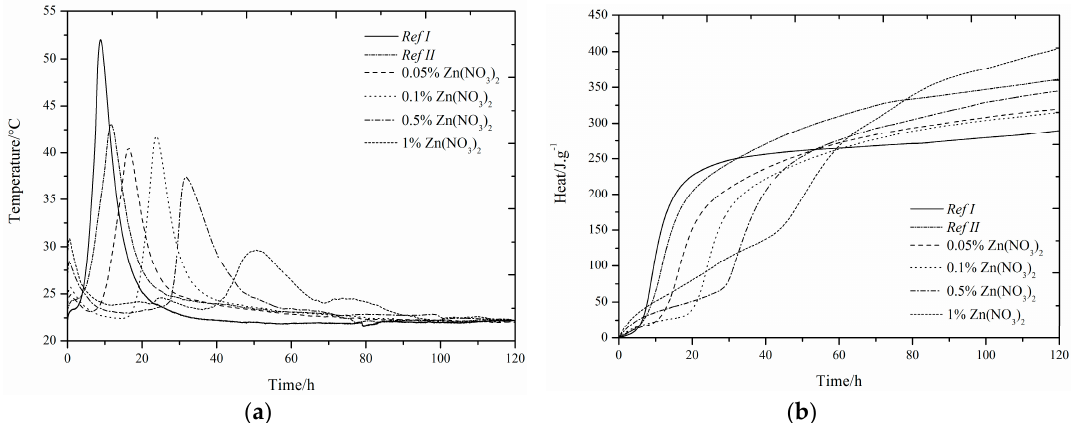
Figure 1. Differential ( a ) and integral ( b ) curves measured for the addition of Zn(NO 3 ) 2 . Figure 1. Di ff erential ( a ) and integral ( b ) curves measured for the addition of Zn(NO